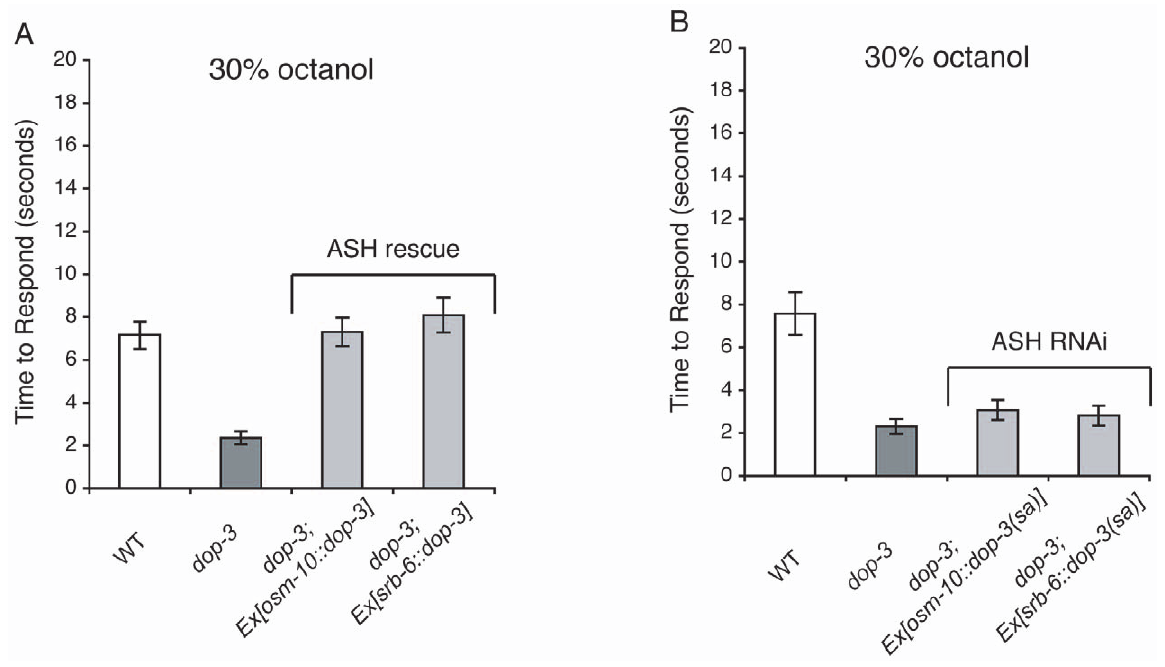
Figure 7. DOP-3 expression in the ASH sensory neurons is sufficient and necessary to modulate sensitivity to dilute octanol. Only the ASH neurons detect dilute octanol [19]. (A) dop-3(vs106) animals with DOP-3 expression rescued in ASH are no longer hypersensitive to dilute (30%) octanol (p . 0.3 when compared to wild-type animals for both transgenes). The osm-10 promoter [40] was used to drive DOP-3 expression in the ASH and ASI head neurons. The srb-6 promoter [9] was used to drive DOP-3 expression in the ASH, ADL and ADF head neurons. (B) RNAi knock- down of dop-3 in the ASH sensory neurons of otherwise wild-type animals, using the osm-10 [40] or srb-6 [9] promoter to co-express dop-3 sense and antisense ( sa ) sequence, resulted in behavioral sensitivity to dilute (30%) octanol, similar to dop-3(vs106) animals (p . 0.2 when compared to dop- 3(vs106) animals for both trangenes). The time to respond is shown. The combined data of $ 3 independent transgenic lines is included for each experiment, n $ 60 transgenic animals. Allele used: dop-3(vs106) . WT =the N2 wild-type strain. Error bars represent the standard error of the mean (SEM).